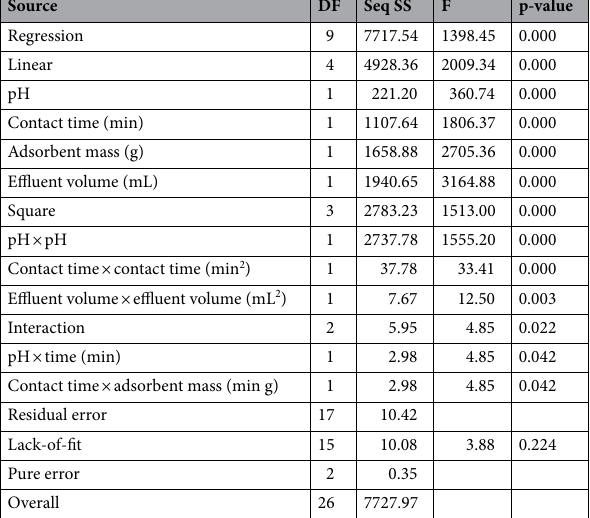
Table 3. Summary of the ANOVA results after eliminating the insignificant independent